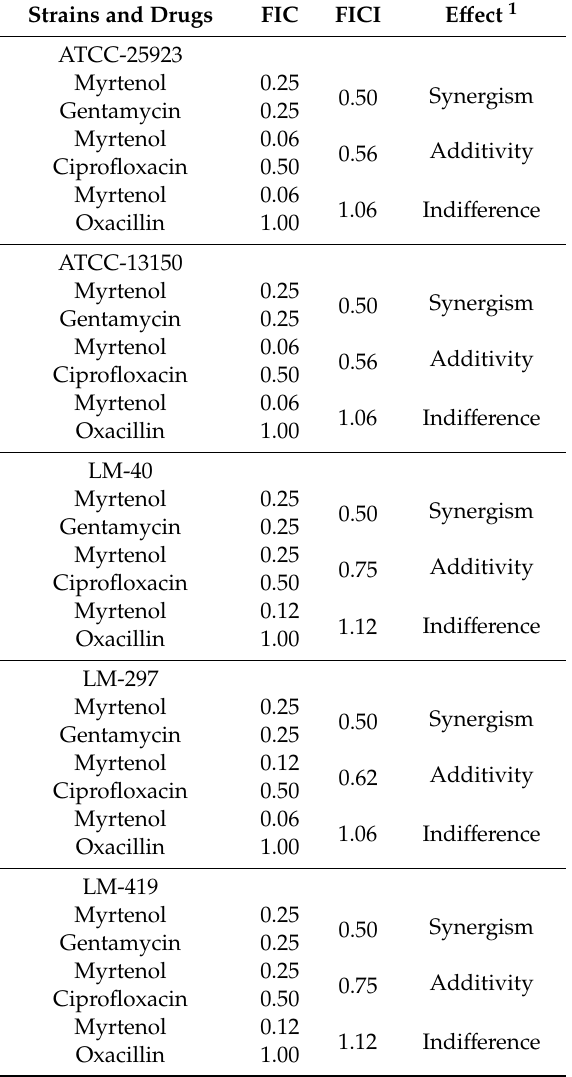
Table 2. Myrtenol in combination with di ff erent antibacterial drugs (checkerboard method). Strains and Drugs FIC FICI E ff ect